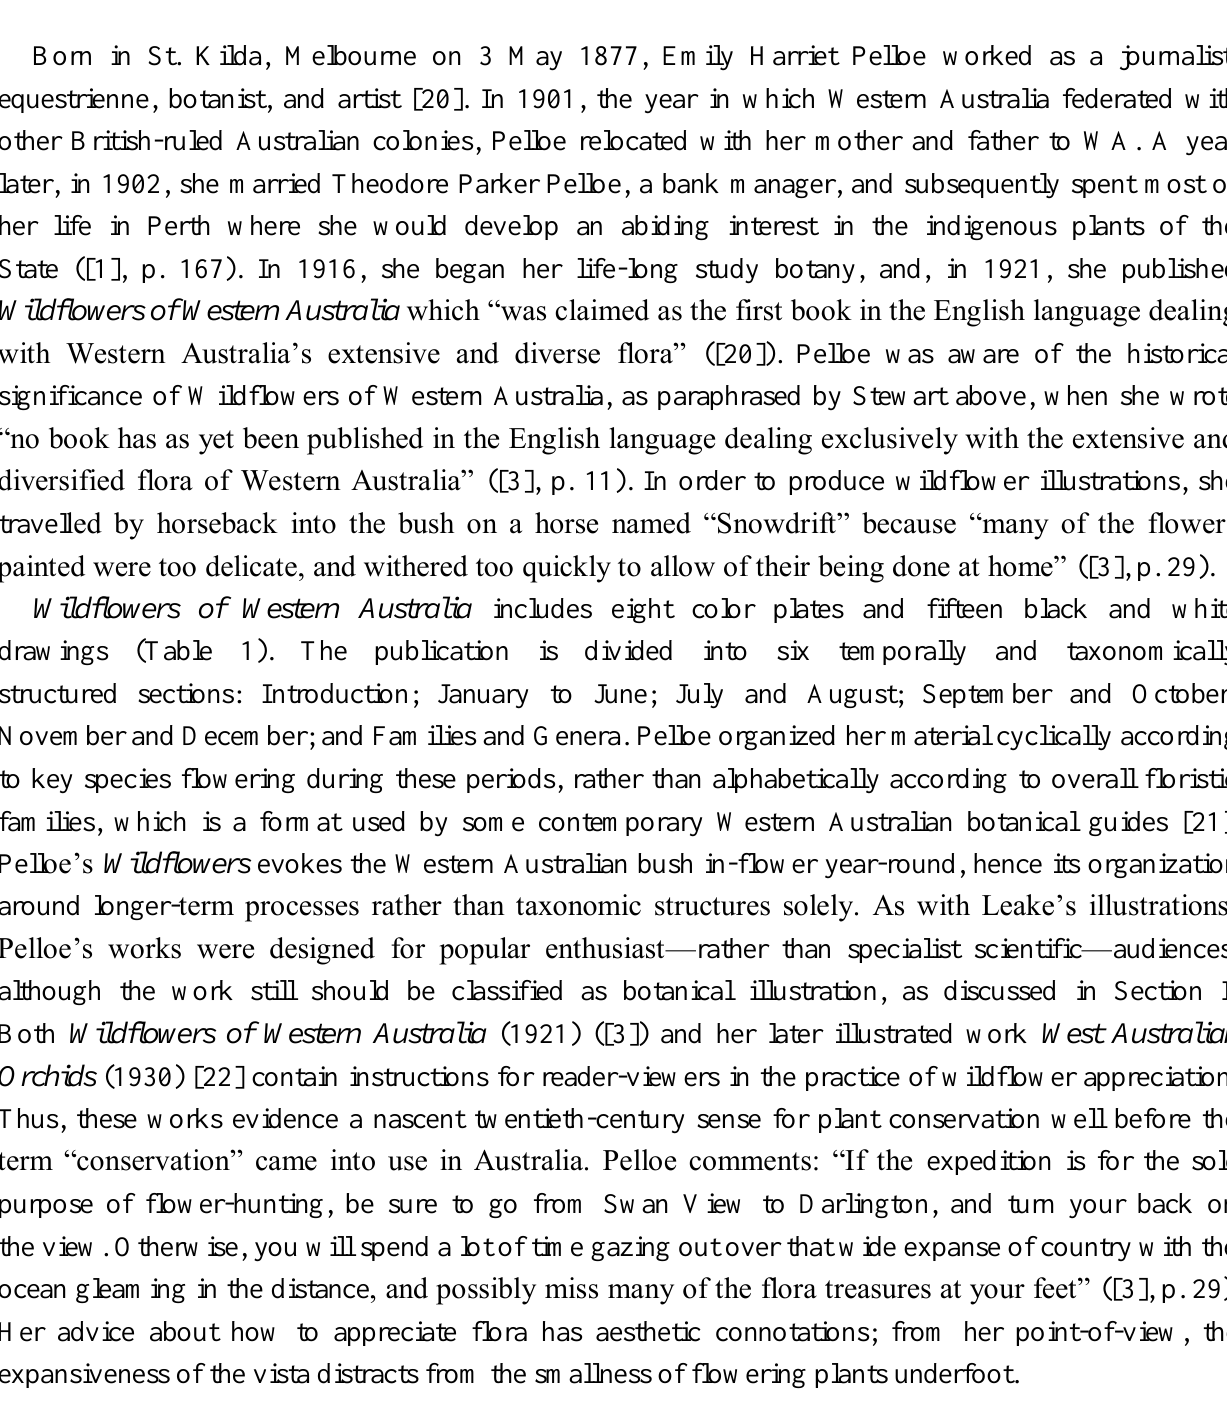
1). The publication is divided into six temporally and